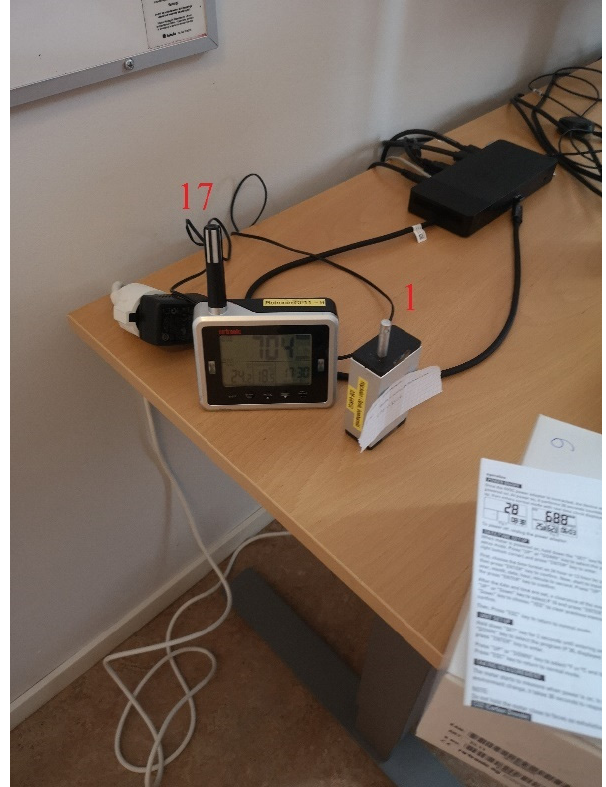
Figure 8. Placement of Loggers 1 and 17 in Room